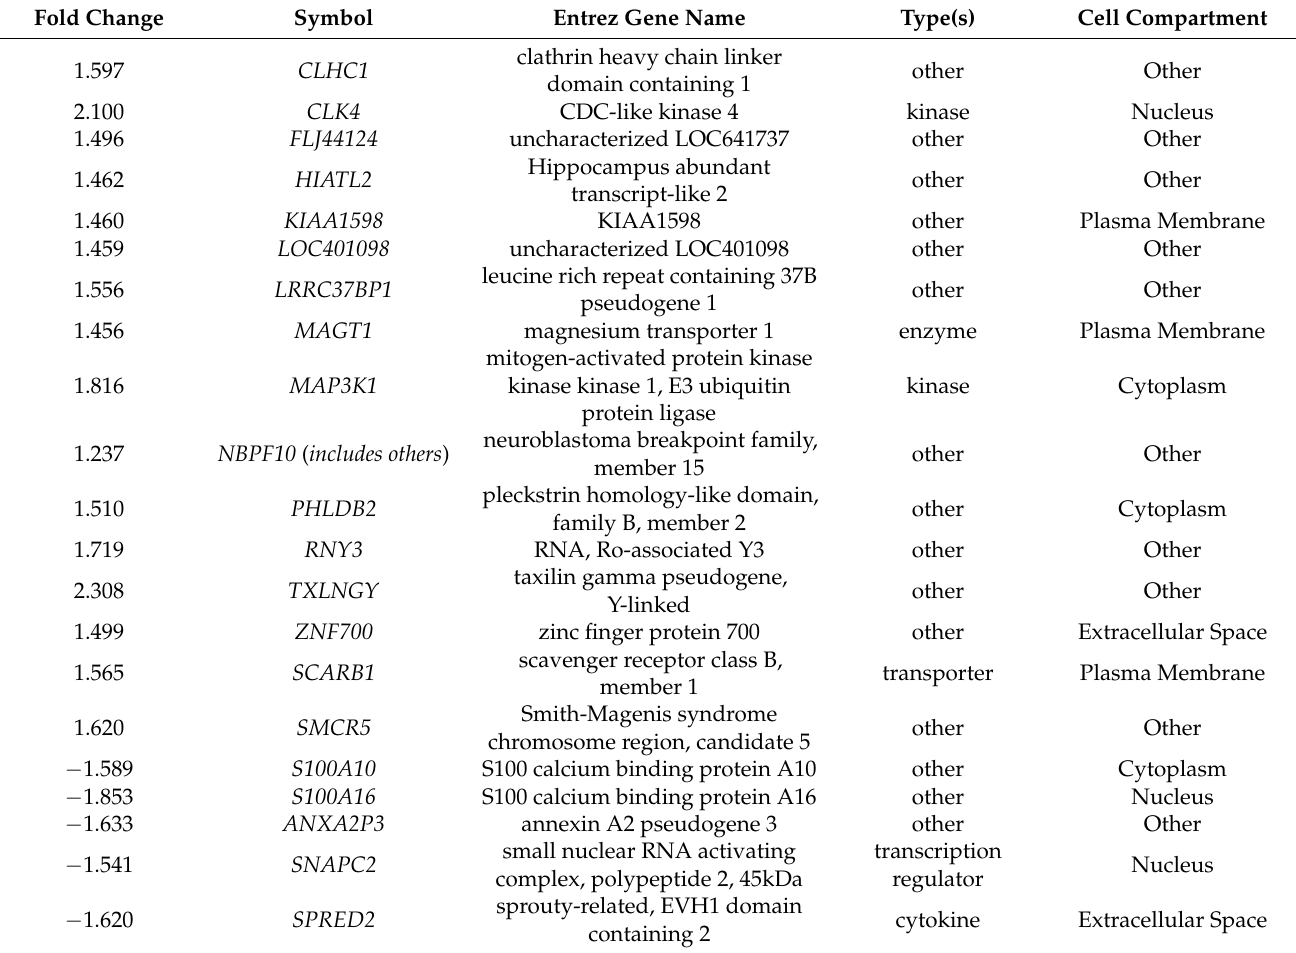
Table 2. Significantly modulated genes in cancer associated fibroblasts ( p < 0.05, FC ±